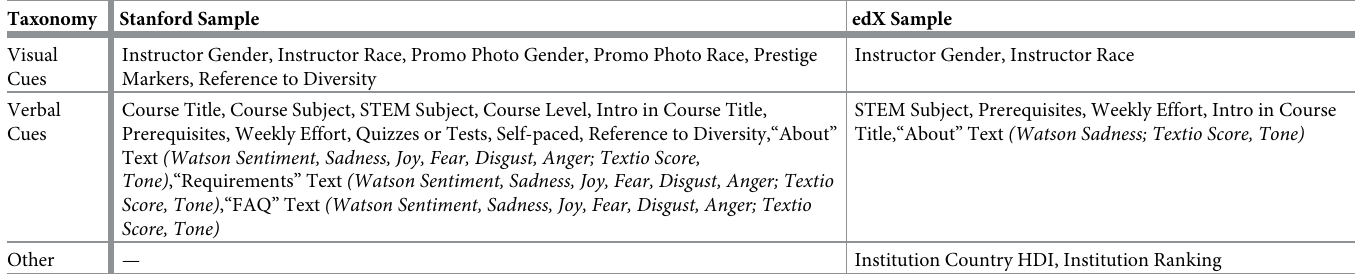
Table 1. Coded features of course enrollment pages in both samples organized by the psychologically inclusive design taxonomy [12]. Taxonomy Stanford